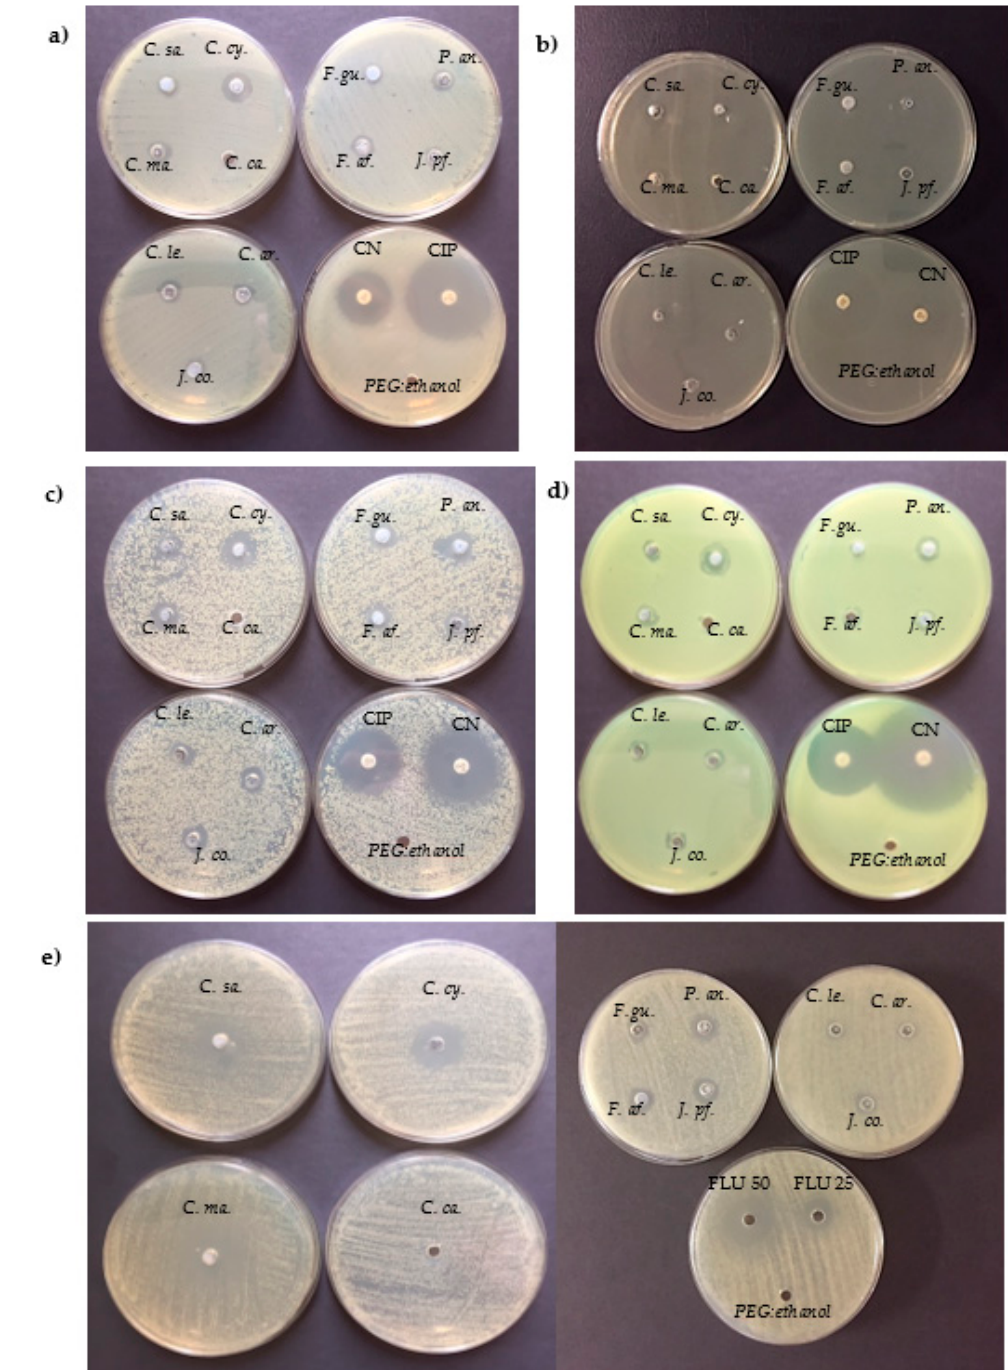
Figure 1. Representative images of growth inhibition diameter (GID; mm) produced by the eleven essential oils (EOs, 10% v / v ) against E. coli ATCC 35218 ( a ), L. monocytogenes ATCC 7644 ( b ), S. aureus ATCC 29213 ( c ), P. fluorescens DSM 4358 ( d ), and C. albicans ATCC 10231 ( e ) determined by AWDM. GID of antibiotics (gentamicin 10 µ g and ciprofloxacin 5 µ g) or antifungal (fluconazole 50 µ g and 25 µ g) as well as PEG:ethanol 50% (used as vehicle) were also presented. C.sa, Cannabis sativa; C.ca., Carum carvi; C.ma., Crithmum maritimum; C.cy., Cuminum cyminum; C.le; x Cupressocyparys leylandii; C.ar., Cupressus arizonica; F.a.f., Ferula assa-foetida; F.gu., Ferula gummosa; J.co., Juniperus communis; J.pf., Juniperus x pfitzeriana; P.an., Pimpinella anisum